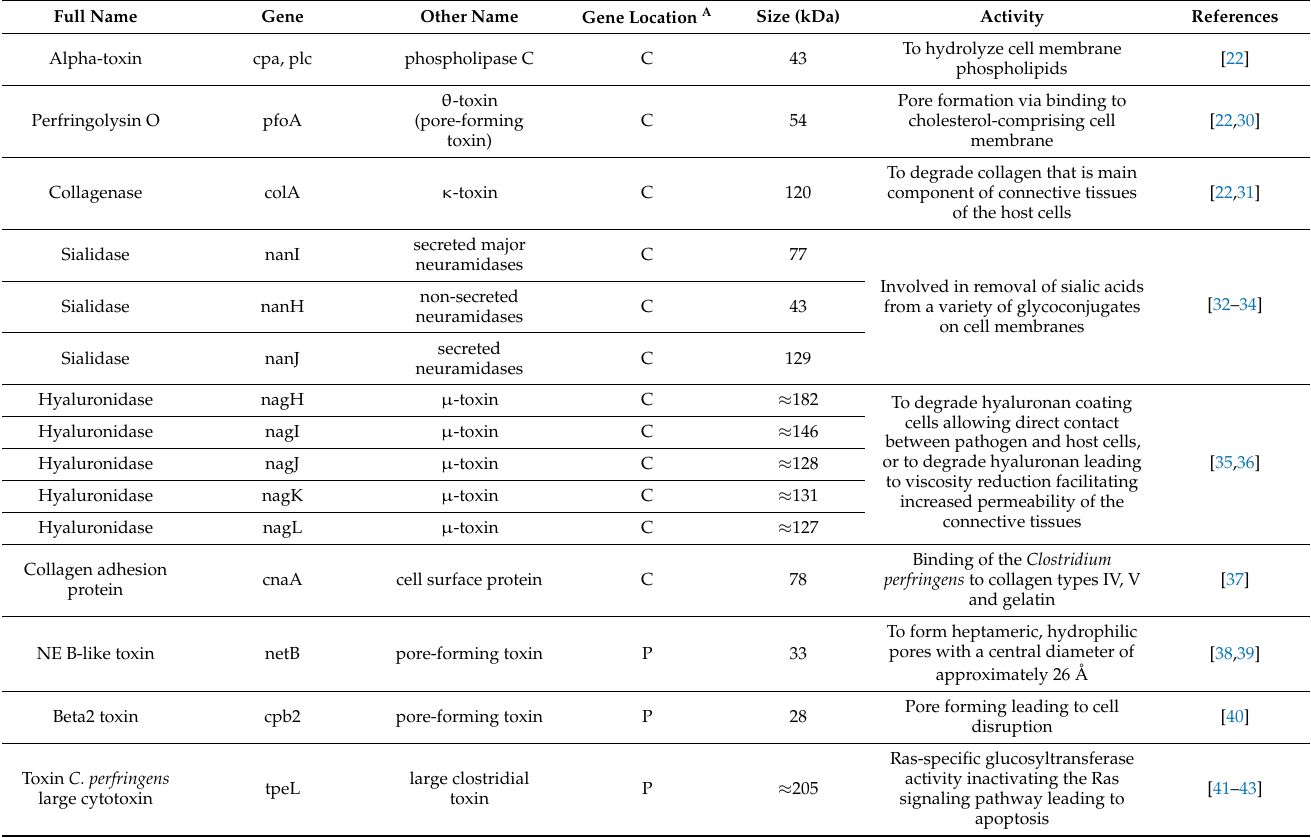
Table 2. Properties of Clostridium perfringens